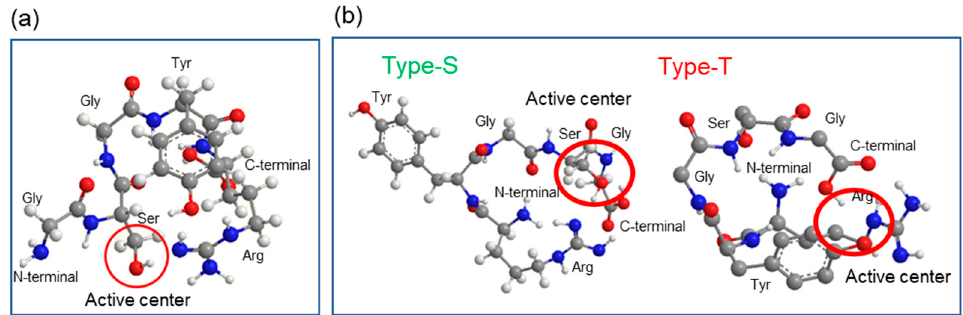
Figure 1. Computer modeling using MM2 and MMFF94 parameters of ( a ) GSGYR and ( b ) RYGSG. Hydrogen atom: white ball; carbon atom: gray ball; oxygen atom: red ball; nitrogen atom: blue ball. Red circle indicates active center.